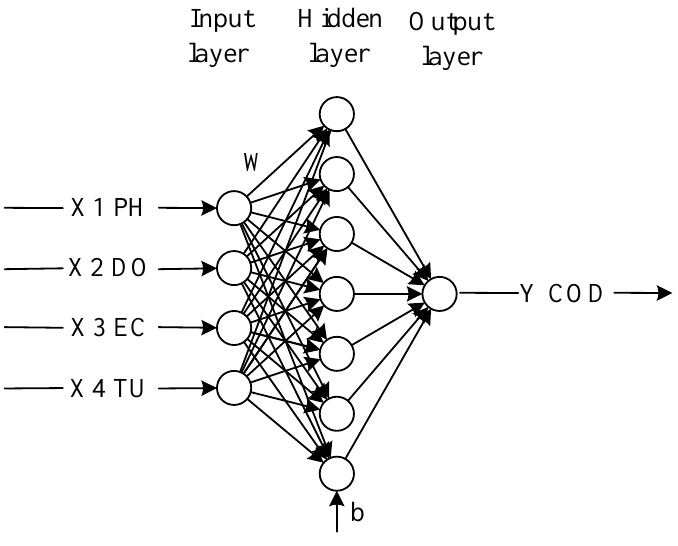
algorithm. A schematic representation of the static water quality parameter model based on the BP neural network (SWQM) is presented in Figure 1.